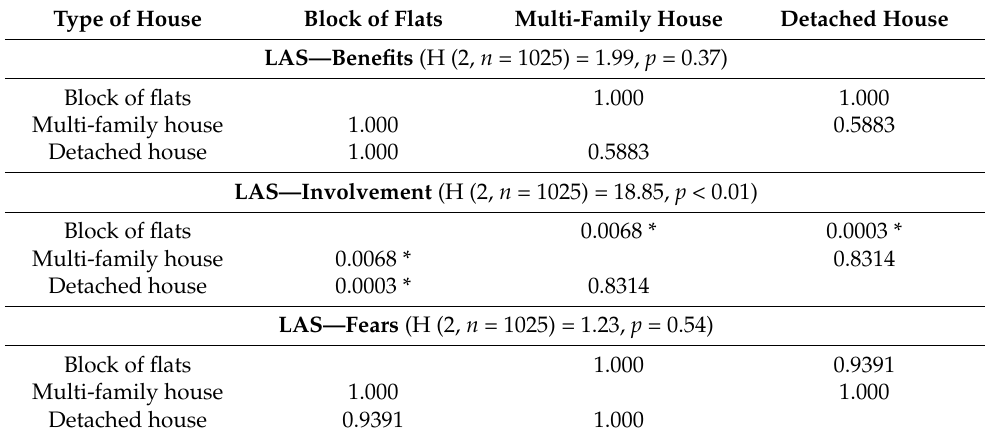
Table 6. The significance of differences between groups in reference to type of the house—results of post-hoc analysis.